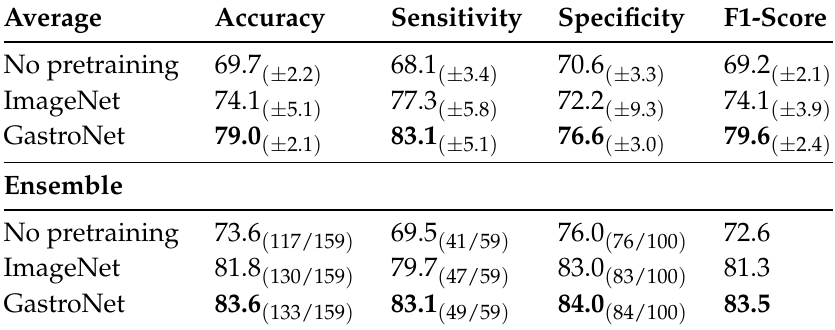
Table 1. NBI-zoom video classification results. The top three rows show the average performances of the 5 obtained models, standard deviation is added between the brackets. The bottom three rows depict the performances of the ensemble predictions. The highest scores per metric are indicated in boldface, for both evaluation